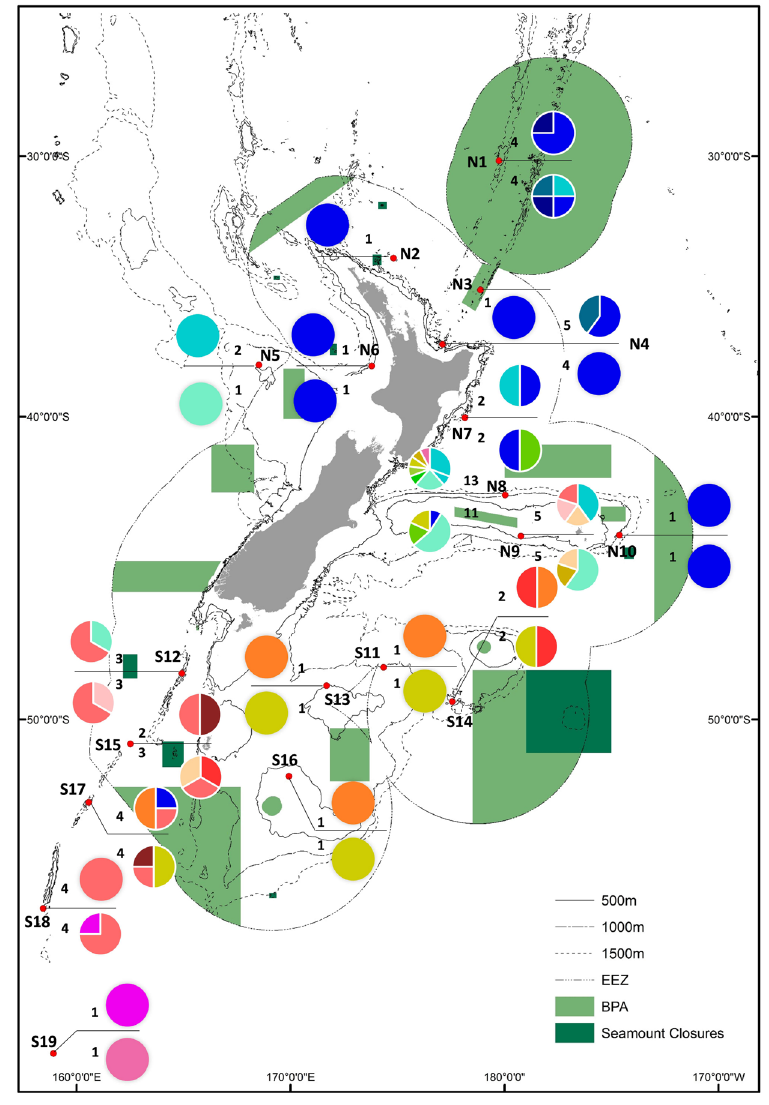
Figure 3. Haplotype map for Poecillastra laminaris COI (above line) and Cytb (below line) overlain with marine protected areas (BPAs and Seamount Closure Areas) within the New Zealand EEZ. Pie graph indicates haplotypic composition of each location and numbers indicate total number of sequences from each